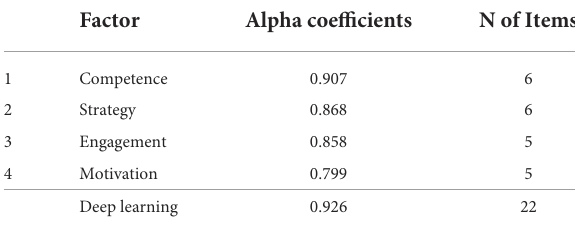
TABLE 4 Cronbach’s alpha coefficients for four sub-dimensions and the overall scale in exploratory factor analysis